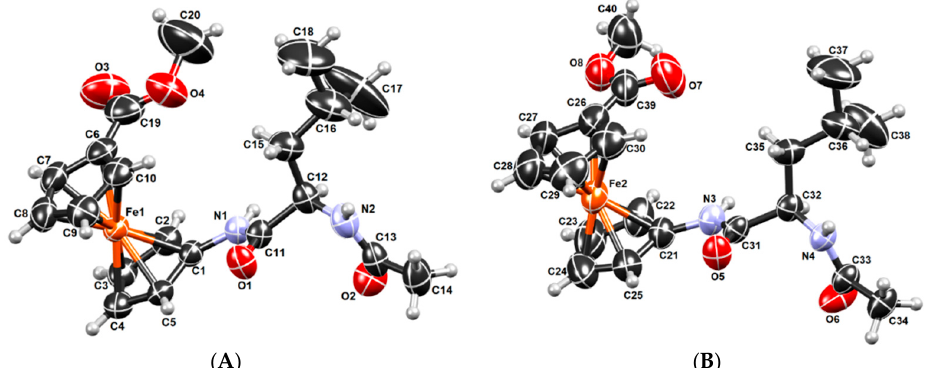
Figure 7. ORTEP-3 [52] drawings of two symmetry-independent molecules of D - 2a with atom numbering scheme: ( A , B ) Displacement ellipsoids are drawn for the probability of 50% and hydrogen atoms are shown as spheres of arbitrary radii.